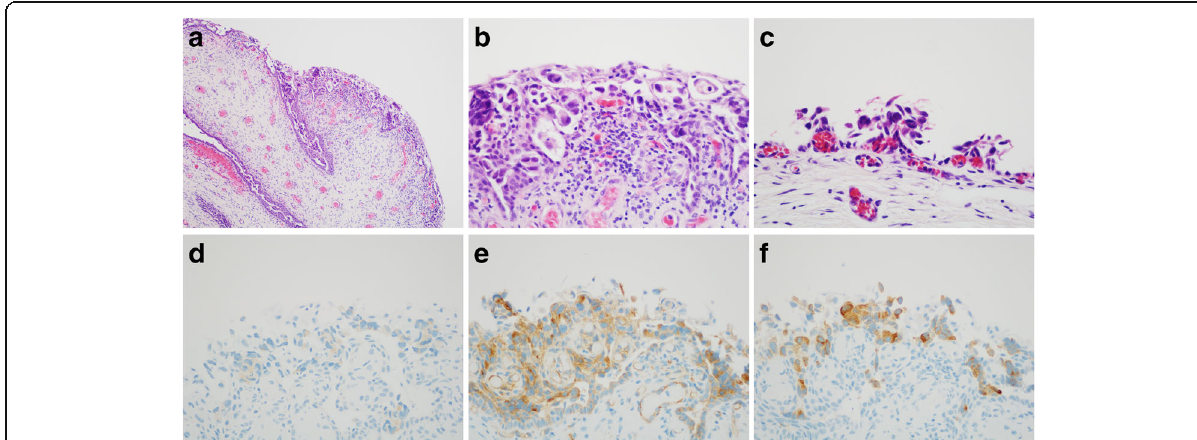
Fig. 2 Photomicrographs of pagetoid urothelial intraepithelial neoplasia extending to the vagina. a – f Punch biopsies from the vulva and anterior vaginal wall. a Large cells proliferating within the basal and parabasal layers of the vulvar squamous epithelium (hematoxylin and eosin [HE] stain, × 10). b Paget-like cells with larger nuclei and paler cytoplasm than the adjacent keratinocytes about clefts, an apparent artifact that is a common finding in pagetoid urothelial intraepithelial neoplasia (HE, × 400). c Similar cells of high nuclear grade identified in the mostly denuded vagina (HE, × 400). d Focal positivity for uroplakin III (immunohistochemical [IHC] stain, × 400). e Positivity for thrombomodulin (IHC, × 400). f Positivity for uroplakin II (IHC, ×